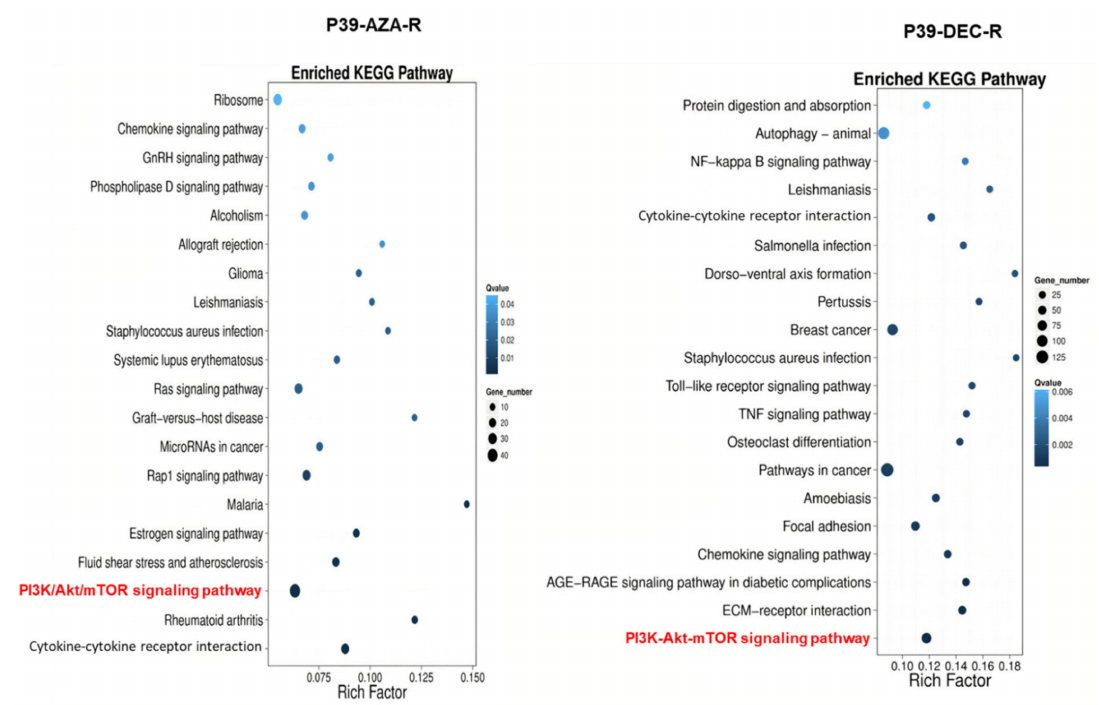
Figure 3. KEGG prediction for pathway and functional roles of differentially expressed genes (DEGs). Functional prediction by KEGG analysis of differentially expressed genes in hypomethylating agent (HMA)-resistant P39 sublines compared with P39 was performed separately for